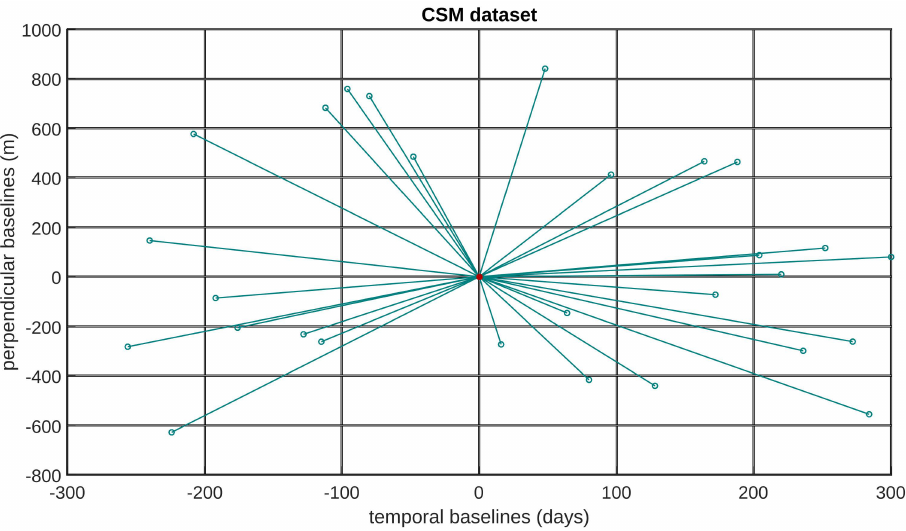
Figure 6. Distribution of the acquisitions, depicted as circles, in the temporal/spatial baseline domain. Red circle corresponds to the master